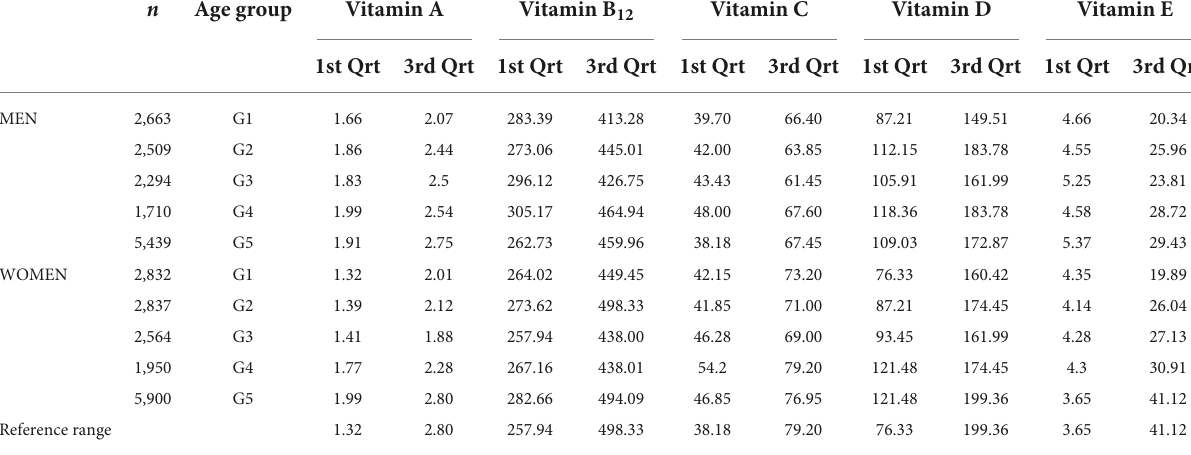
TABLE 1 Reference interval of blood concentration of vitamin A ( µ mol/L), B12 (pmol/L), C ( µ mol/L), D (nmol/L), and E (Mmol/L) concentrations stratified by age group in men. n Age group Vitamin A Vitamin B 12 Vitamin C